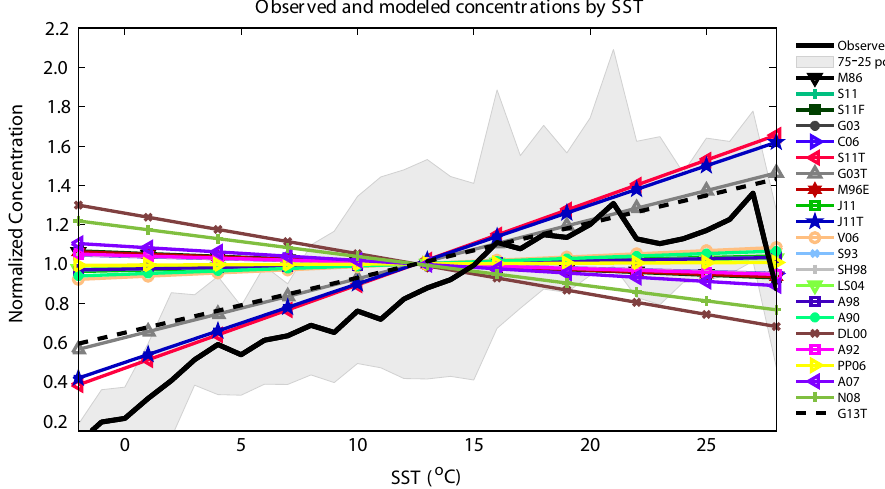
Fig. 10. Same as Fig. 9, but for source-region average temperature and with a first-order polynomial fit for the source functions. Data points were used only when the source average wind was in the range 5–10ms − 1 (for acronyms in the legend, see Table